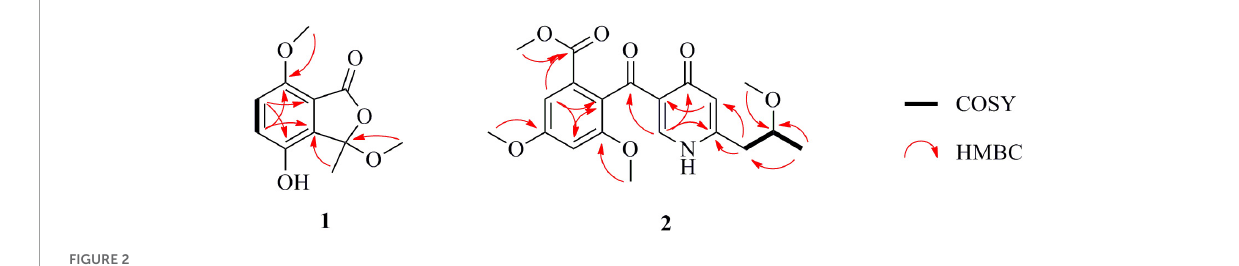
FIGURE2 Key COSY and HMBC correlations for 1 and 2 .